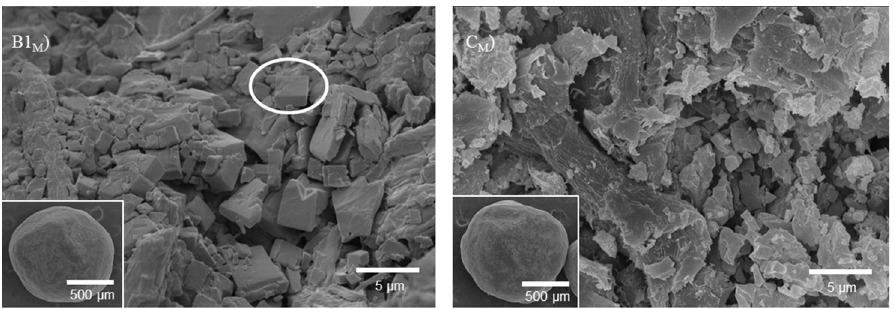
Figure 8. Micrographs (SEM) of a cross section and pellets (inserts) from formulations B 1M ( left ) and C M ( right ). The circle in the left micrographs shows a crystal of OLZ dihydrate.